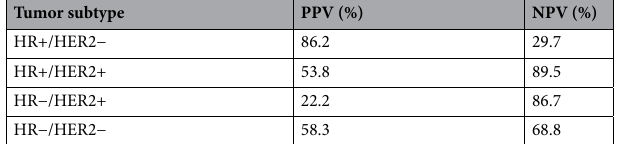
Table 3. Accurate prediction rate of nodal status after NAC determined by AUS according to tumor subtype. NAC neoadjuvant chemotherapy, AUS axillary lymph node ultrasound, HR hormone receptor , HER2 human epidermal growth factor receptor